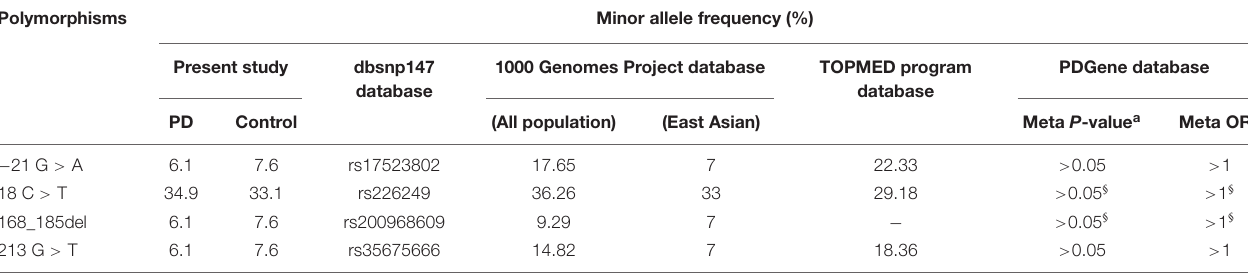
TABLE 5 | The frequencies of polymorphisms detected in present study and in public databases.